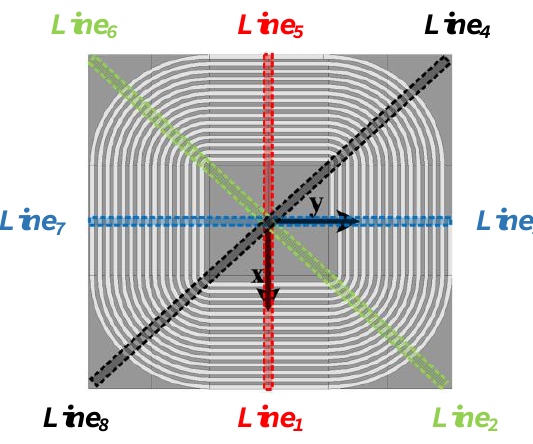
Figure 6. Diagram of typical offset direction.